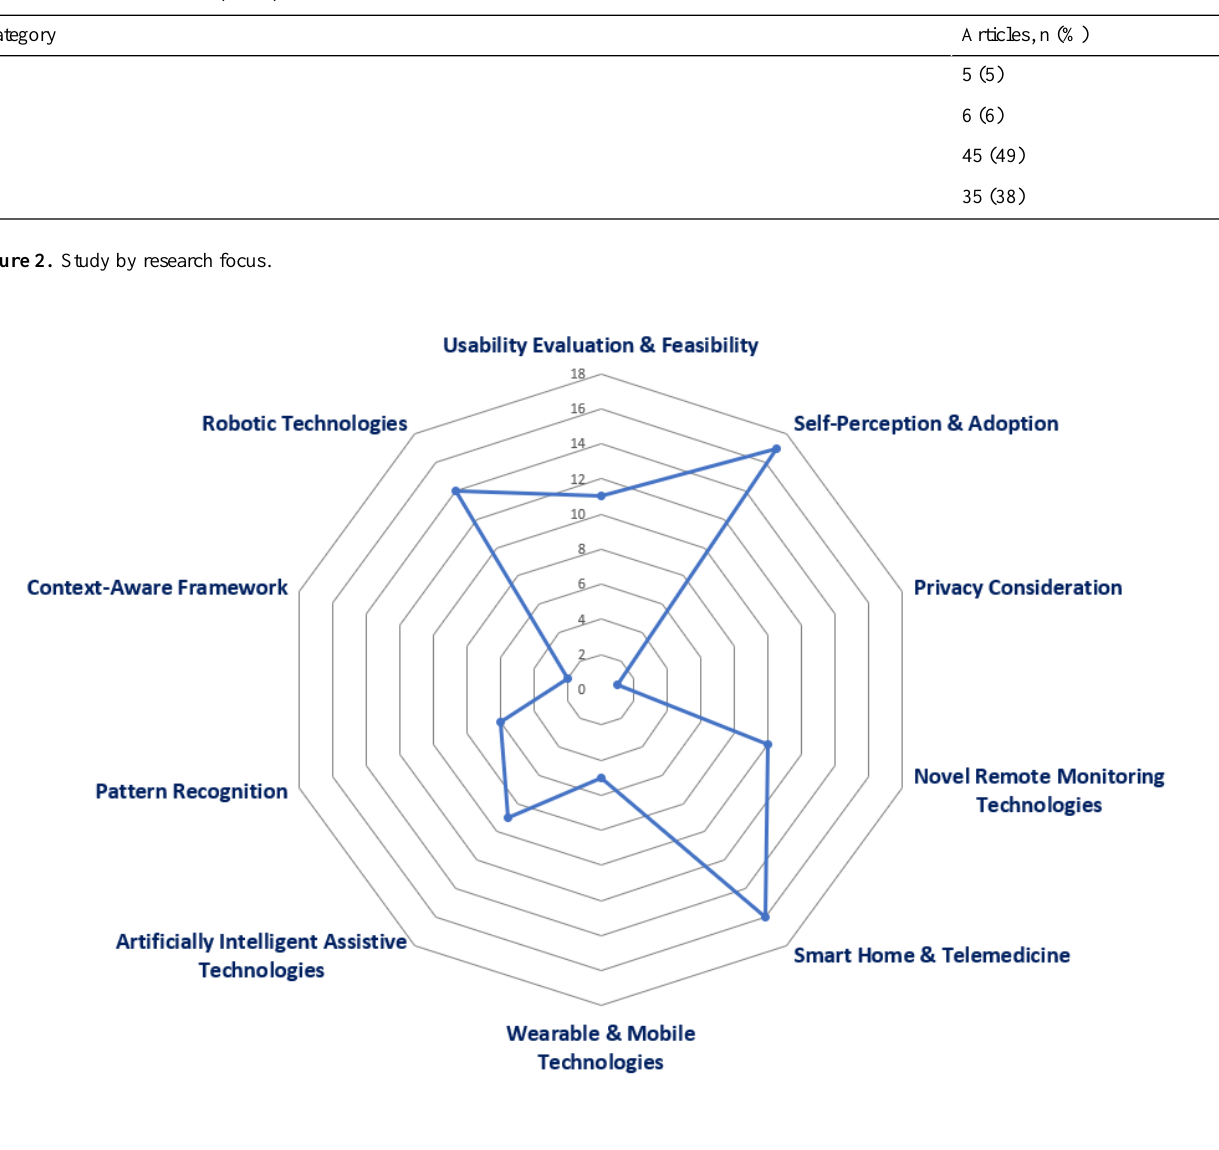
Table 4. Levels of evidence (N=91).